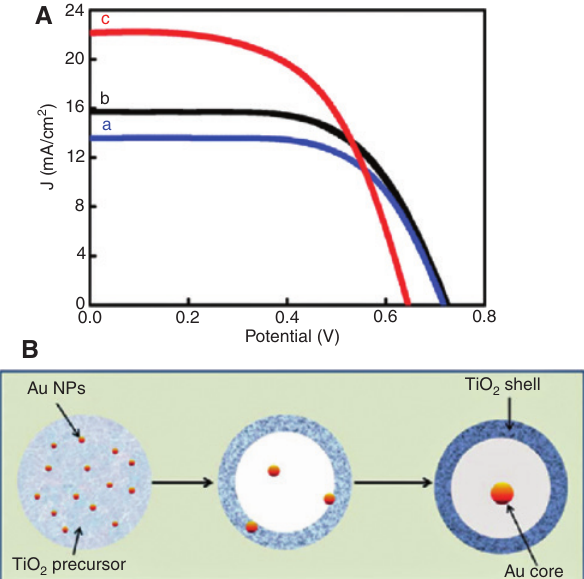
hollow submi- 2 hollow submicrospheres 2 2